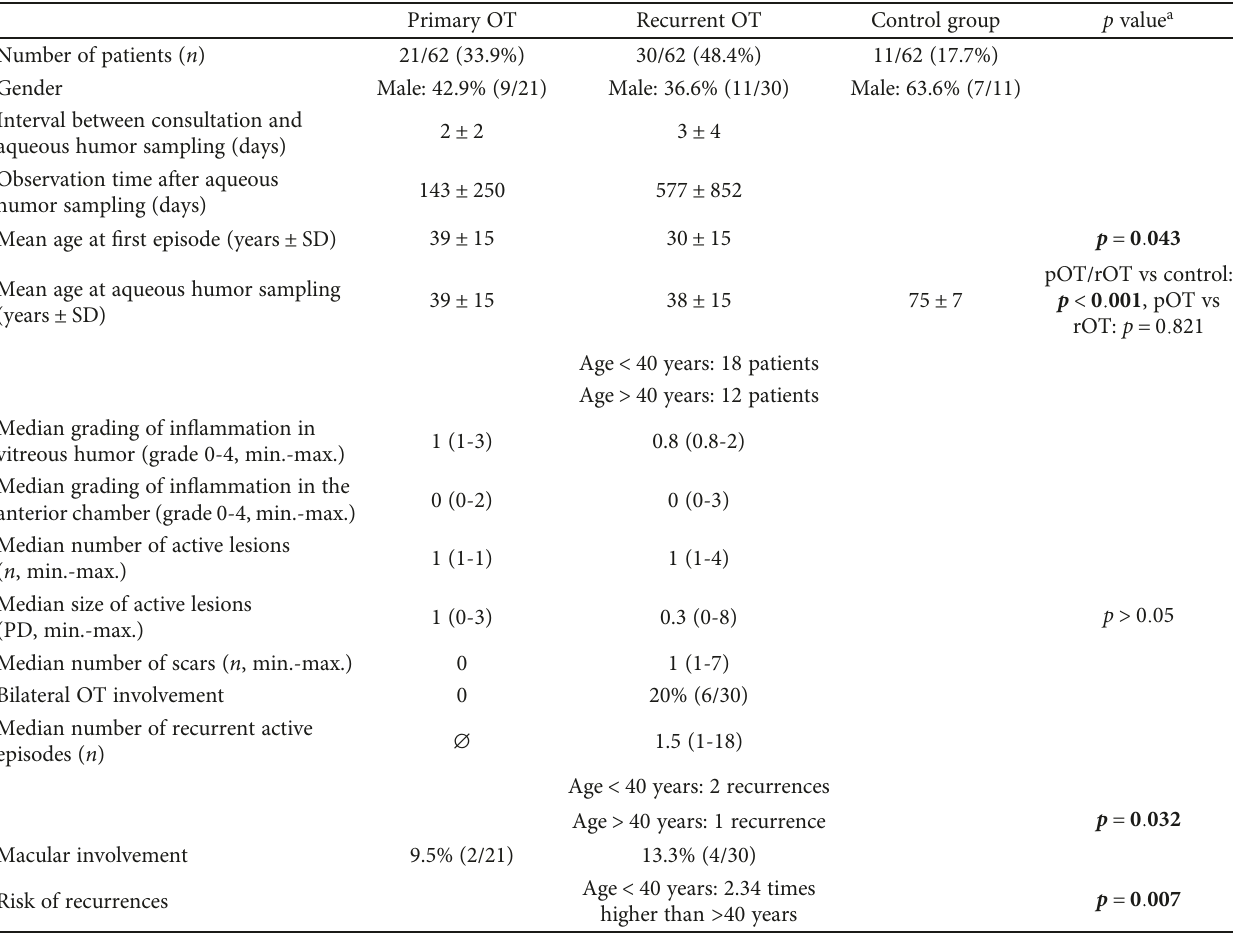
Table 1: Clinical characteristics of the patient in the primary and recurrent OT groups and control